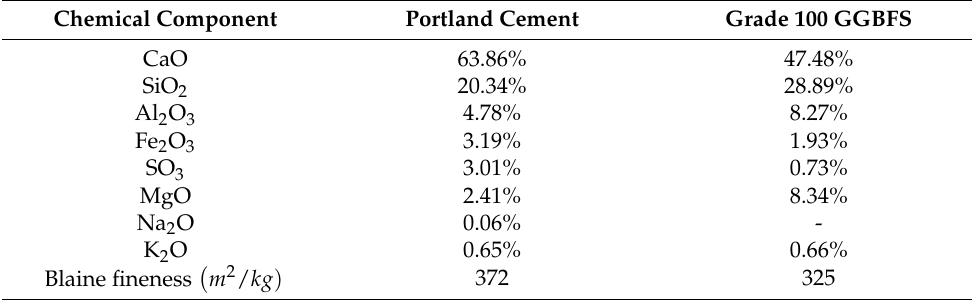
Table 3. Chemical composition of cementitious